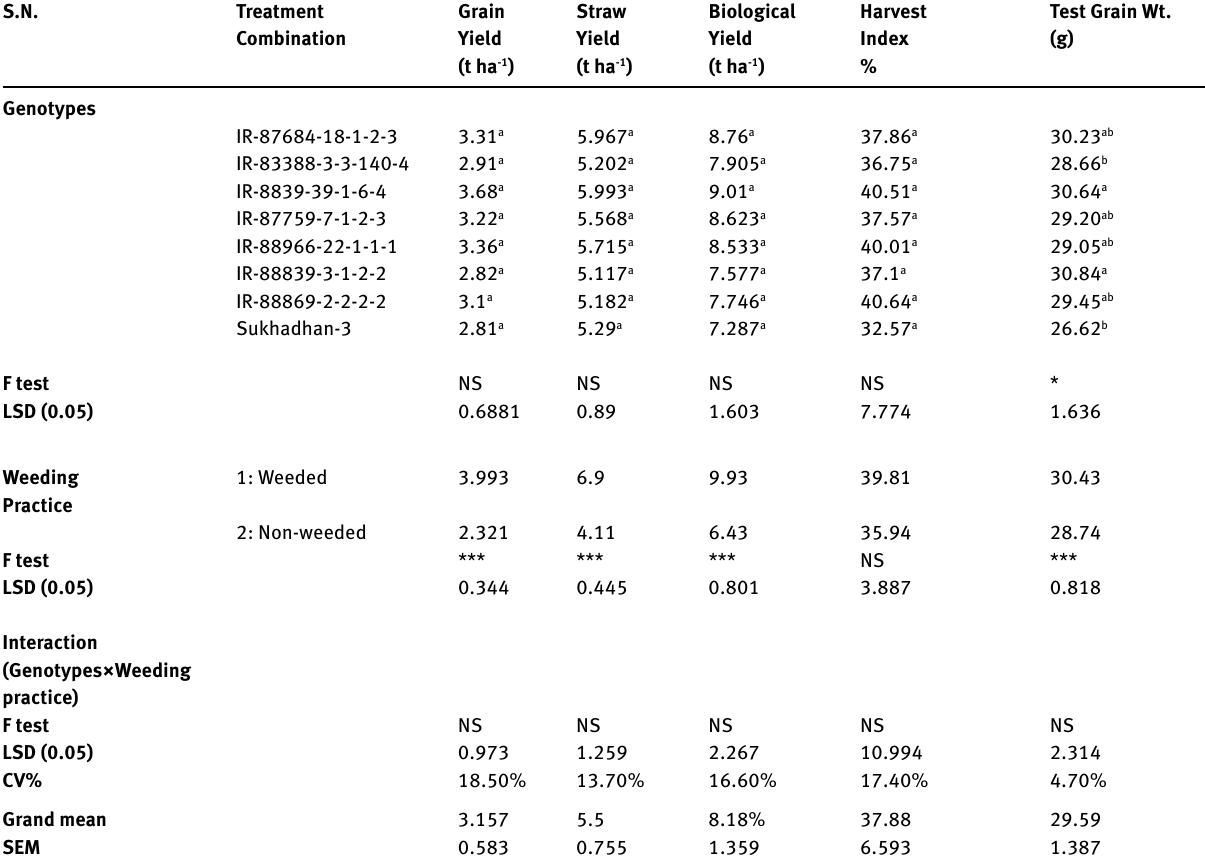
Table 2: Effect of genotypes, weed management practices and their interaction on yield traits of rice genotypes at Lamjung, Nepal, 2016